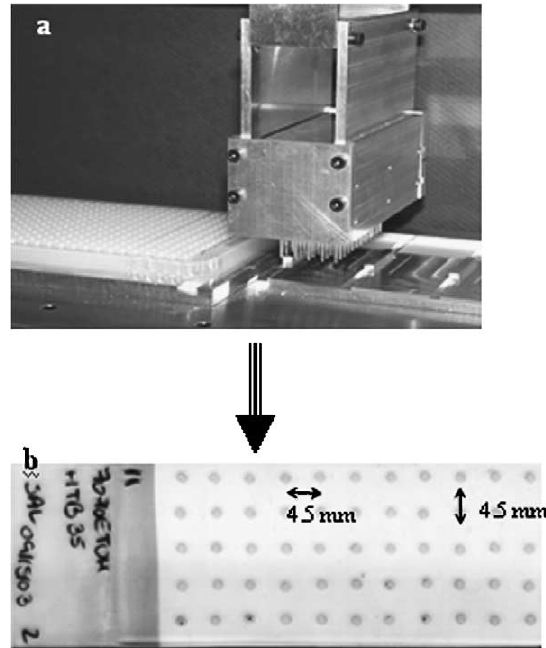
Fig. 2. (a) The automated cytology microarray depositing device. (b) The scan of a stamped and stained glass slide after preparation. action, but ensured that the cell suspensions remained evenly mixed between deposition